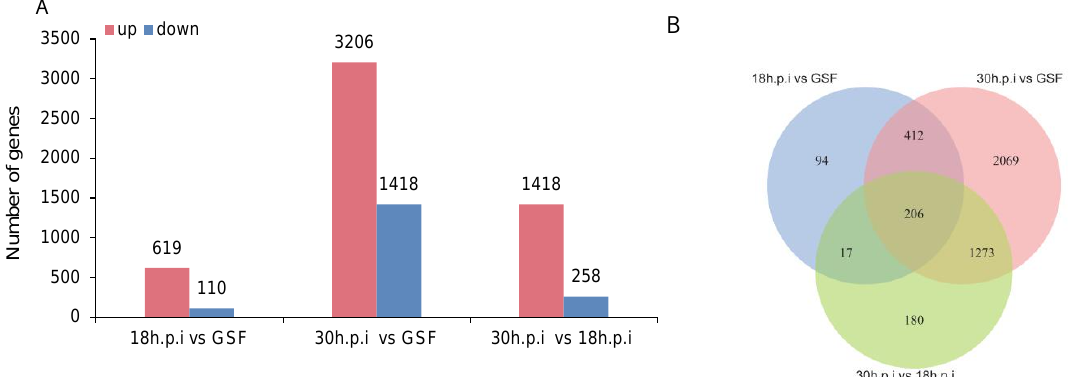
Figure 4. DEGs in 18h.p.i vs. GSF, 30h.p.i vs. GSF and 30h.p.i vs. 18h.p.i. ( A ) Bar chart of DEGs in 18h.p.i vs. GSF, 30h.p.i vs. GSF, and 30h.p.i vs. 18h.p.i. ( B ) Venn diagram of DEGs in 18h.p.i vs. GSF, 30h.p.i vs. GSF, and 30h.p.i vs.